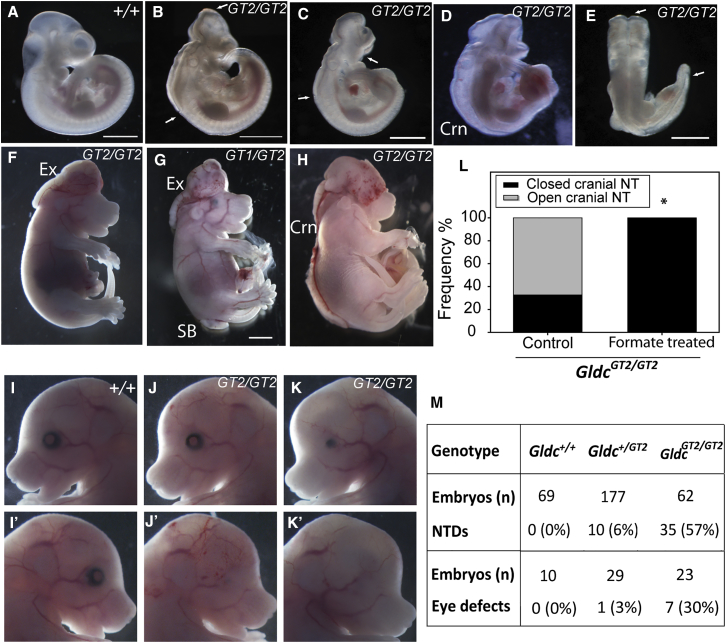
Loss of Function of the GCS Causes Neural Tube Defects(A–E) Cranial neural tube closure is complete in a Gldc+/+ embryo at E10.5 (A), whereas, in GldcGT2/GT2 embryos (B–E), the neural folds remain open (region between arrows) in the mid-hindbrain (B), fore-hindbrain (C), or throughout the entire mid-hindbrain and spinal region (craniorachischisis [Crn], D and E).(F–H) At later stages (F–H, E15.5), failed closure in the brain, low spine, or entire brain and spine leads to the typical appearance of exencephaly (Ex, F and G), spina bifida (SB, G), and Crn (H), respectively (scale bars represent 1 mm).(I–K) Among litters examined at E16.5–18.5, unilateral (J and J’) or bilateral (K and K’) eye defects were frequently observed among Gldc mutant fetuses but not in the wild-type (I and I’).(L) Maternal formate supplementation prevents NTDs in GldcGT2/GT2 embryos (n = 10 untreated, 9 formate-treated; ∗p < 0.02, Fisher’s exact test).(M) Frequency of NTDs among litters from GldcGT2/+ intercrosses (n = 38 litters analyzed).Data for eye defects are included for a subset of litters analyzed at E14.5–16.5. See also Table S3.